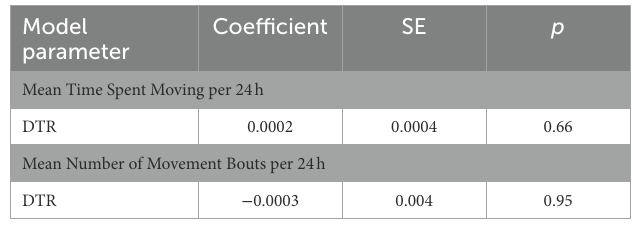
TABLE 4 Coefficients, standard error, and p -values for ACT derived annual movement model parameters.